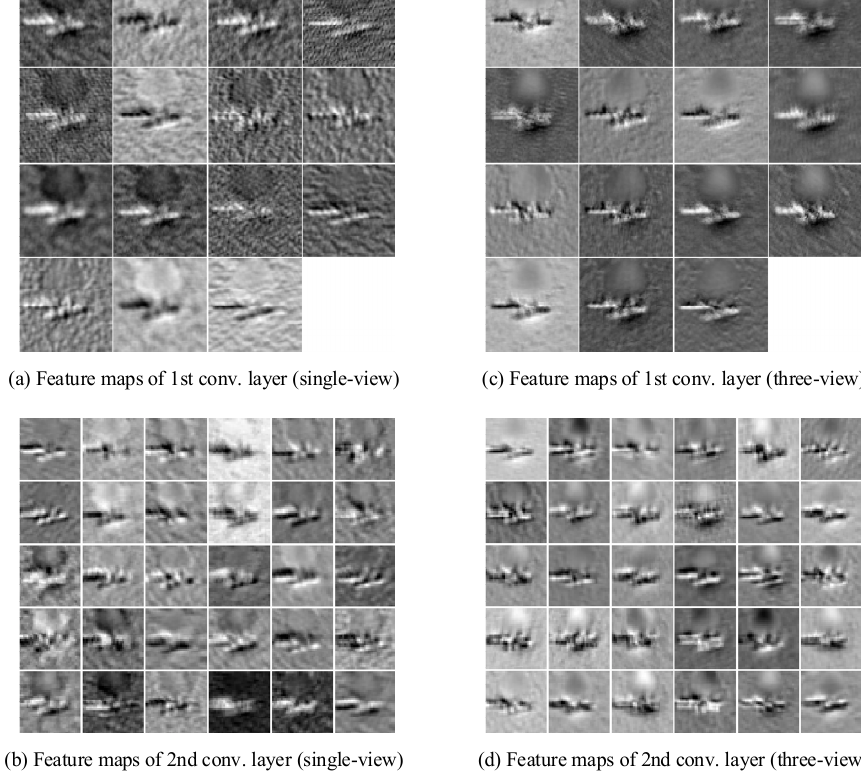
Figure 6. Comparison of recognition degree of feature maps.